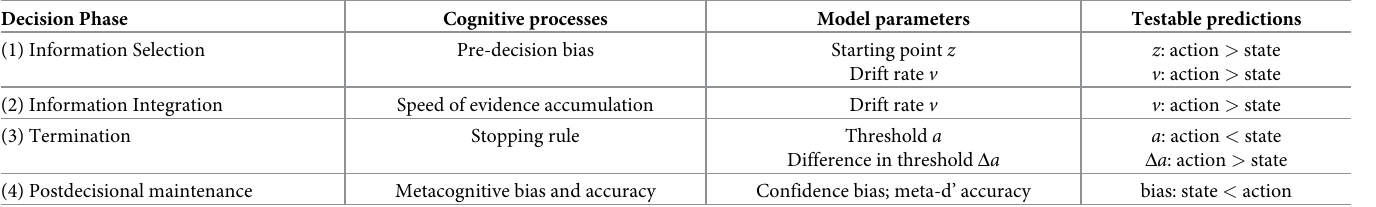
Table 2. Parametrization of tested hypotheses based on the model of decision-making process by Dibbelt and Kuhl [36] and operationalized using Drift Diffusion Model [42] and meta-d’